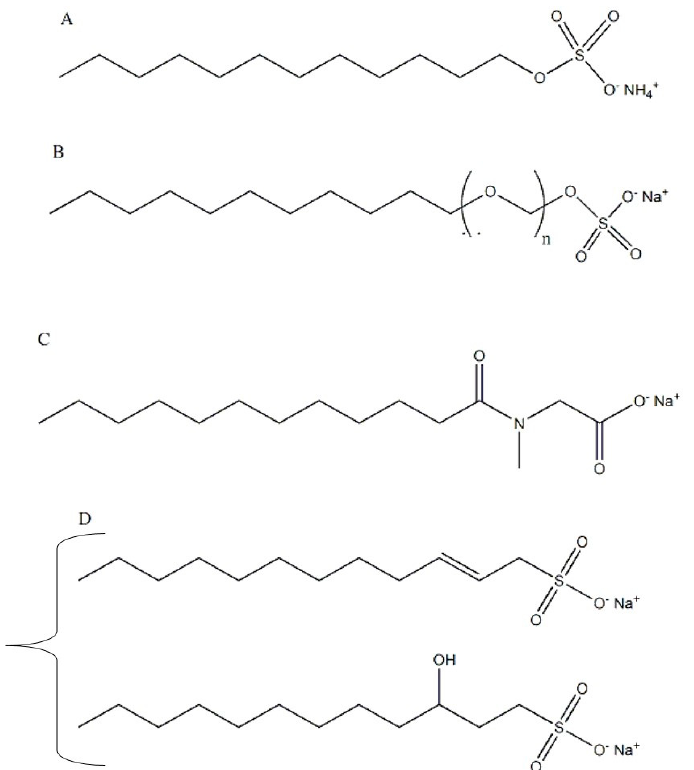
Figure 2. Structure of some anionic surfactant using the example of the C12 chain length representatives: ( A ) Ammonium lauryl sulfate; ( B ) Sodium laureth sulfate; ( C ) Sodium lauroyl sarcosinate; ( D ) Dodecyl alpha olefin sulfonate, Sodium salt.